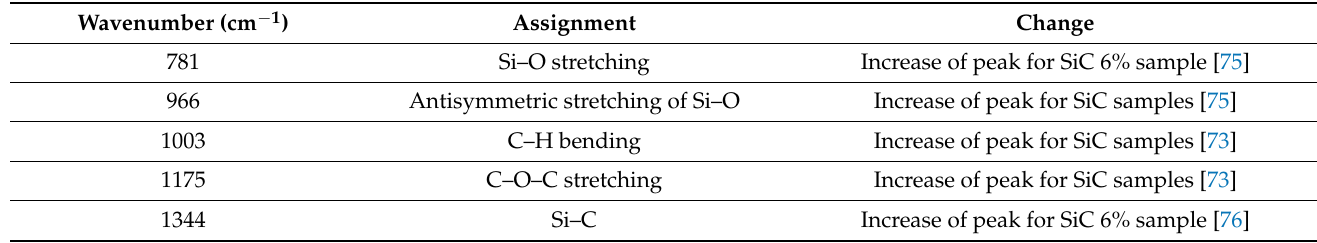
Table 1. The Raman spectra differences in behavior (clear PC and PC/SiC nanocomposites).